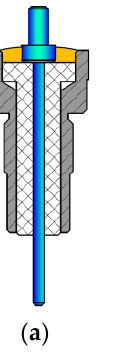
Figure 1. Ion probe design in the form of a ( а ) needle and ( b ) spark plug.